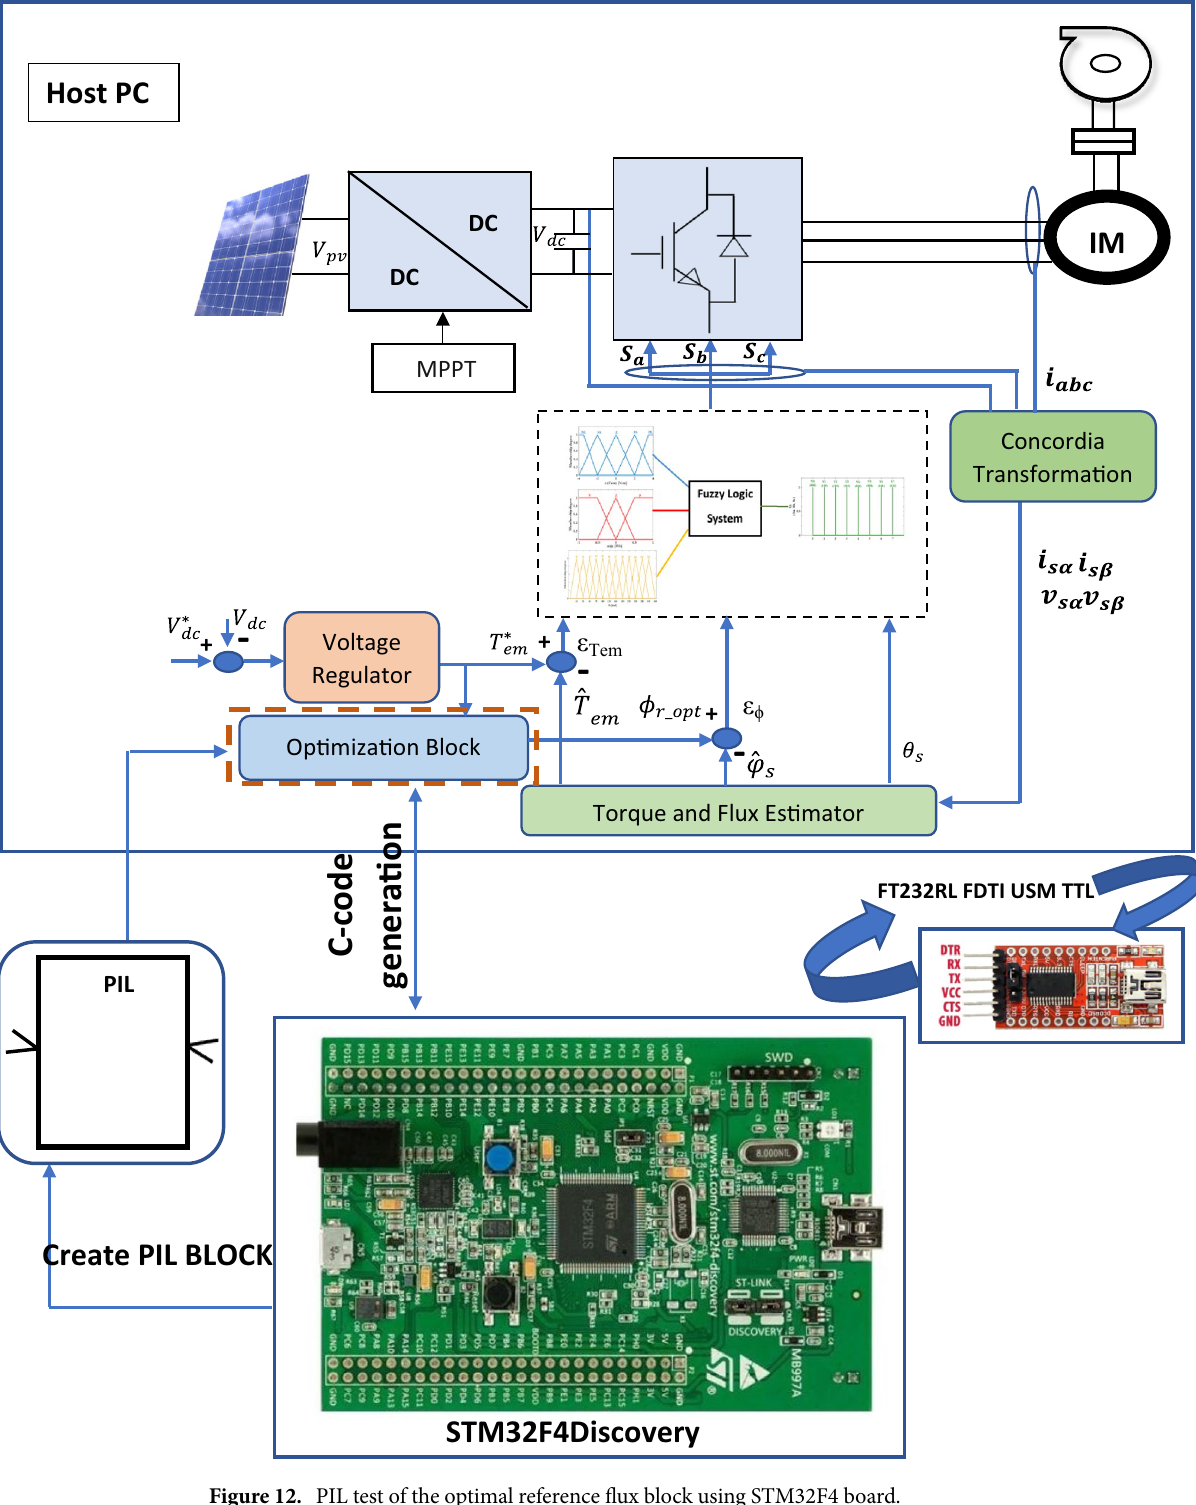
Figure 12. PIL test of the optimal reference flux block using STM32F4